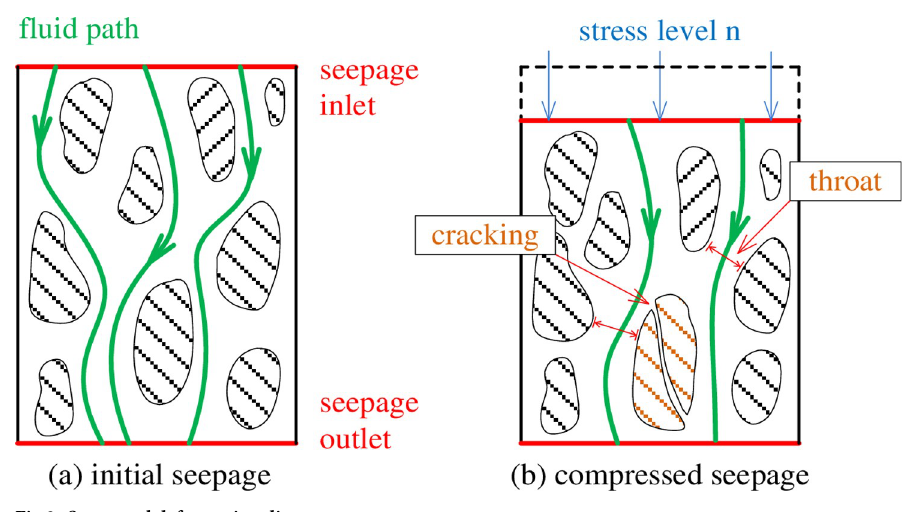
Fig 2. Structural deformation diagram.